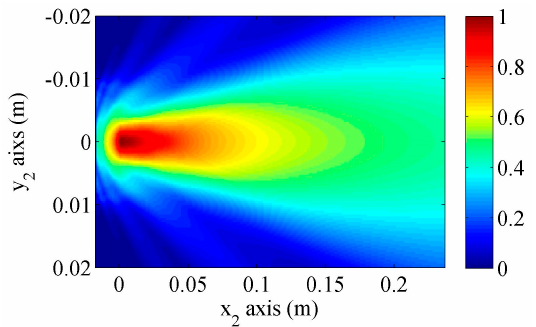
Figure 6. Rayleigh wave beam distributions on the surface predicted by the proposed model when the Rayleigh wave attenuation is neglected.